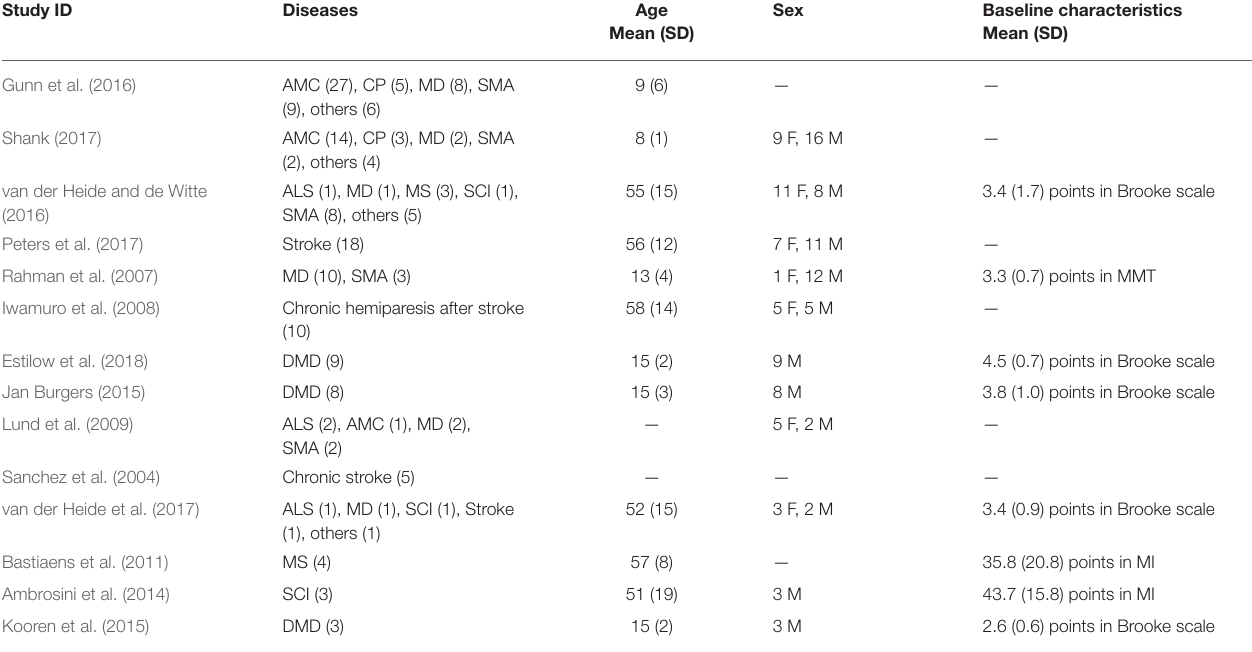
TABLE 4 | Participants’ characteristics in studies.